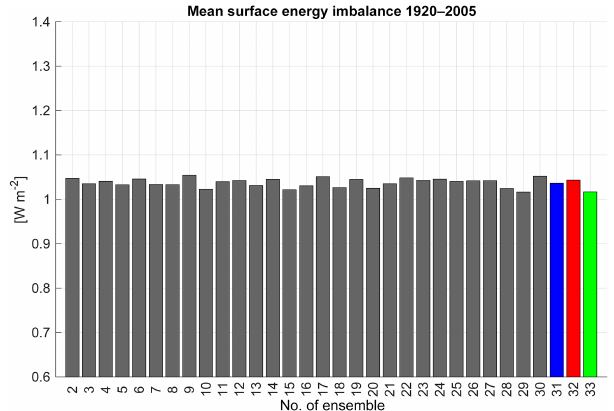
Figure 7. Mean surface energy imbalance from 1920 to 2005 for CESM-LE members 2–30 and new members 31–33 with adjusted compression level ( fpzip -24) for LHFLX. Note that members 31 and 33 have been subjected to lossy